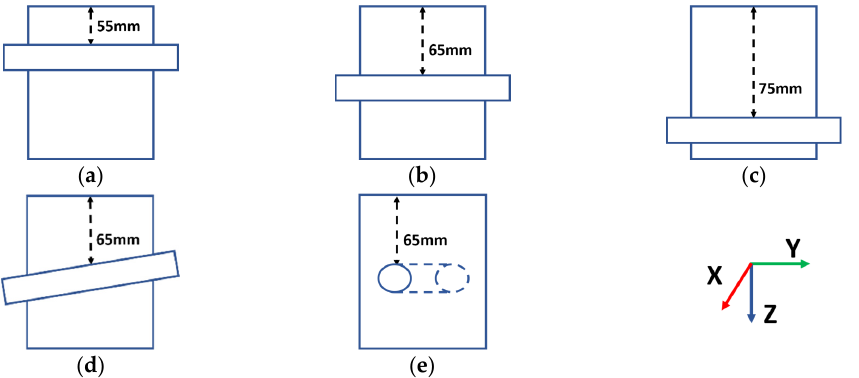
Figure 13. Illustrations of the basic structures of the lab phantoms. From ( a – e ), the phantoms are named the 55 mm phantom, the 65 mm phantom, the 75 mm phantom, the Angle V phantom and the Angle H phantom, respectively.